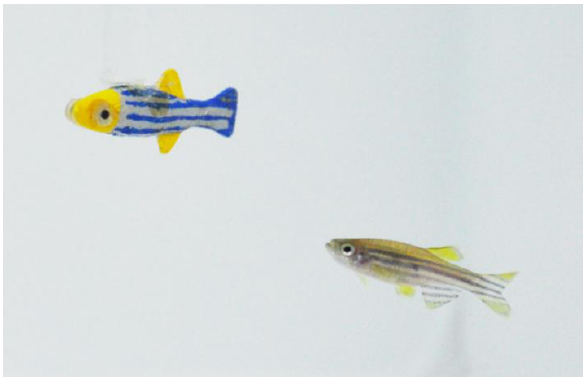
Figure 4 . Zebrafish swimming close to an improved 3D-printed life-sized replica with glass eyes, suspended by a transparent rod.